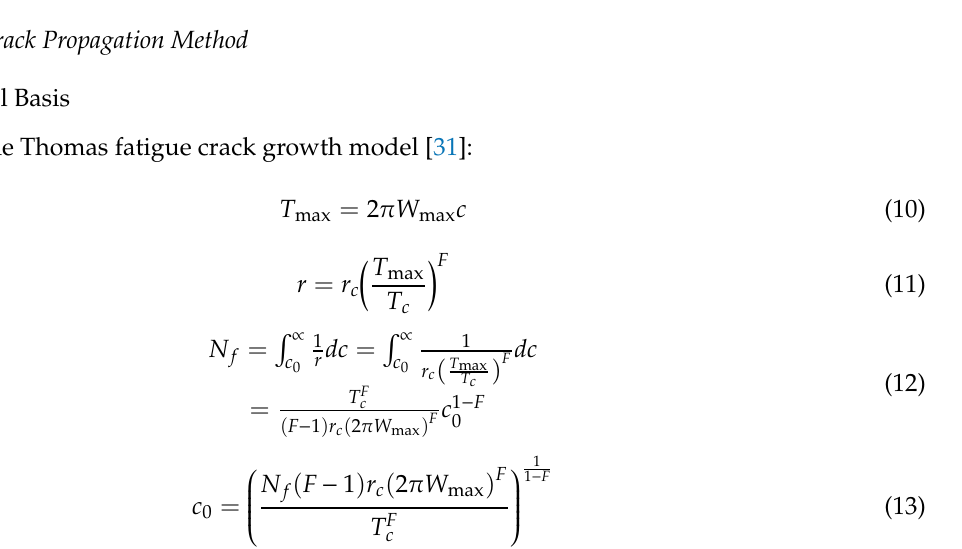
Table 3. Crack growth rates for di ff erent tear energy.